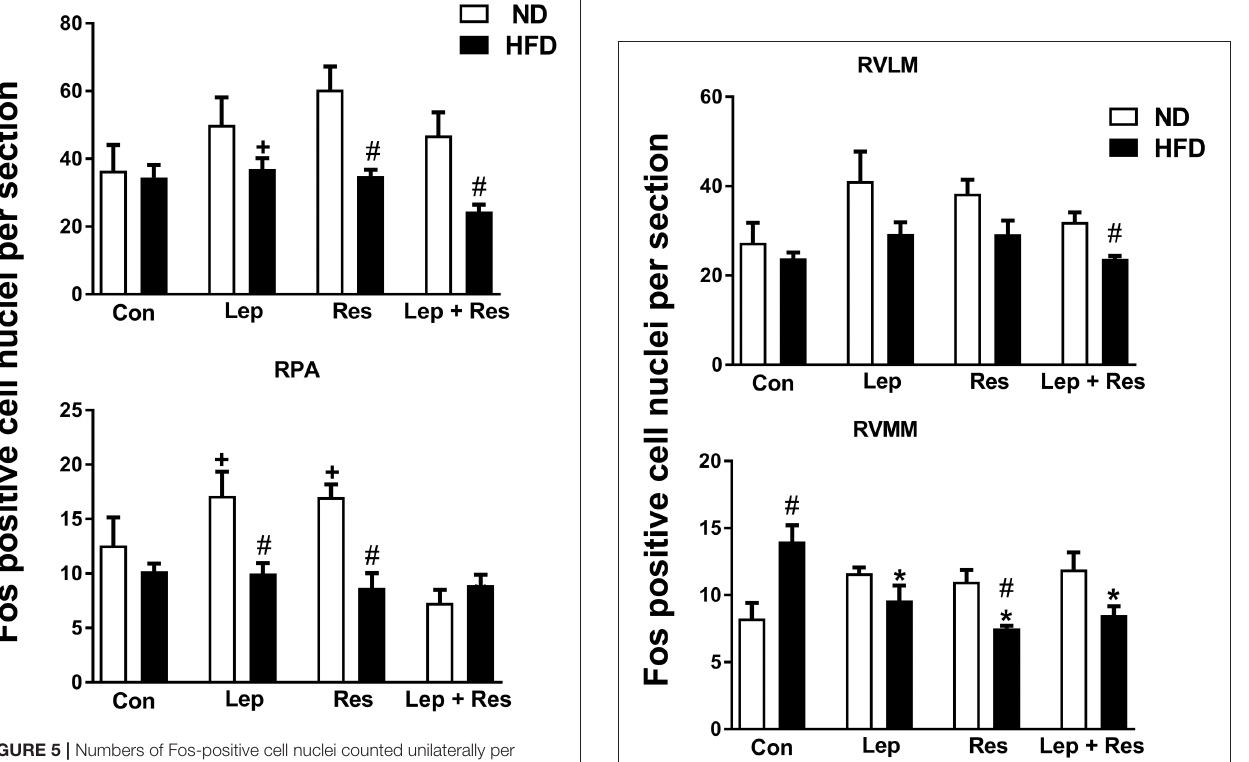
FIGURE 6 | Numbers of Fos-positive cell nuclei counted unilaterally per section in the rostral ventrolateral medulla (RVLM) and rostral ventromedial medulla (RVMM) from rats fed a normal chow (ND) and a high fat diet (HFD) administered intracerebroventricular saline (control, n = 4 ND, n = 4 HFD; 5 µ l), leptin ( n = 4 ND, n = 5 HFD; 7 µ g in 5 µ l), resistin ( n = 4 ND, n = 4 HFD; 7 µ g in 5 µ l), or leptin combined with resistin ( n = 5 ND, n = 6 HFD). * 0.005 < P < 0.05 compared with control. # 0.005 < P < 0.05 HFD compared to